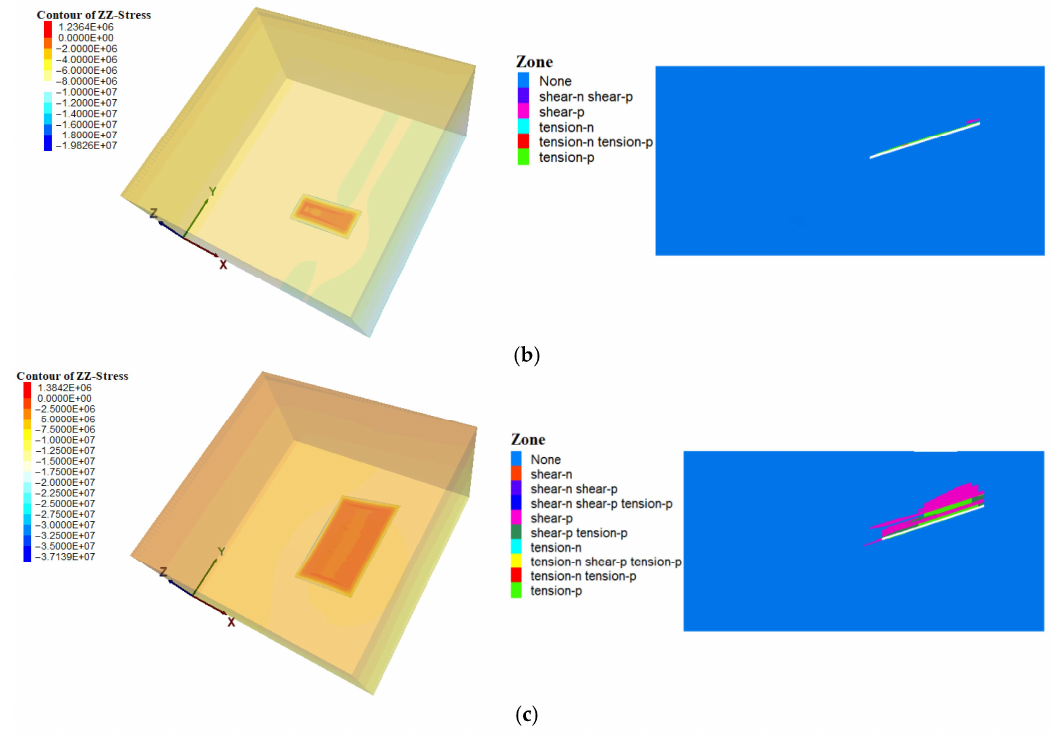
Figure 7. The contour of z-stress ( left ) and plastic damage profile in the extraction zone ( right ): ( a ) excavation 30 m, ( b ) excavation 50 m, and ( c ) excavation 250 m.